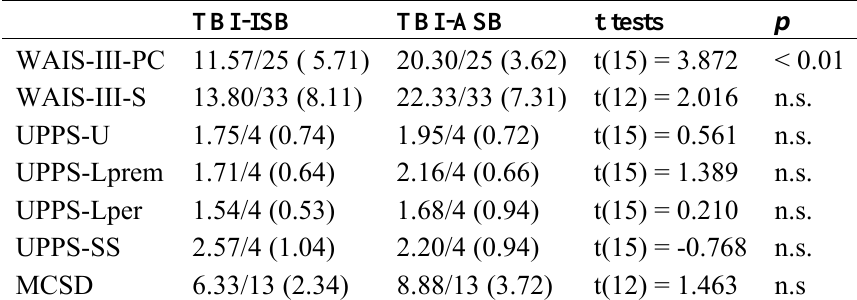
Table 6. Descriptive statistics on control measures for TBI